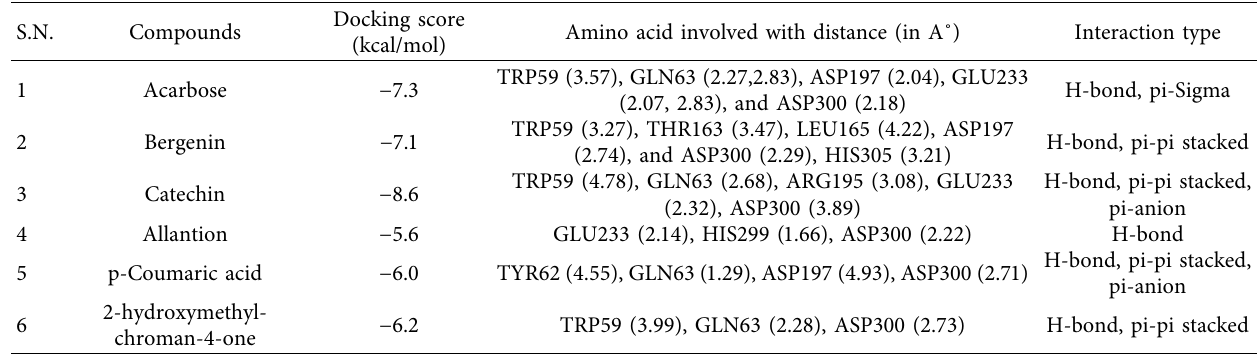
Figure 3: 2D and 3D structure of (a): acarbose, (b): bergenin, (c): catechin, (d): allantoin, (e): p-Coumaric acid, (f): 2-hydroxymethyl- chroman-4-one. Table 6: Binding energy of compounds and interacting amino acid residues of the